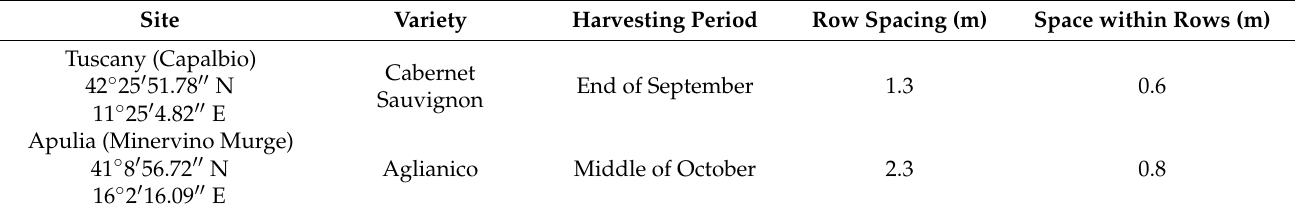
Table 1. Sites and crop details of the vineyards where Isonet CGX111 dispensers were tested to manage Cryptoblabes gnidiella